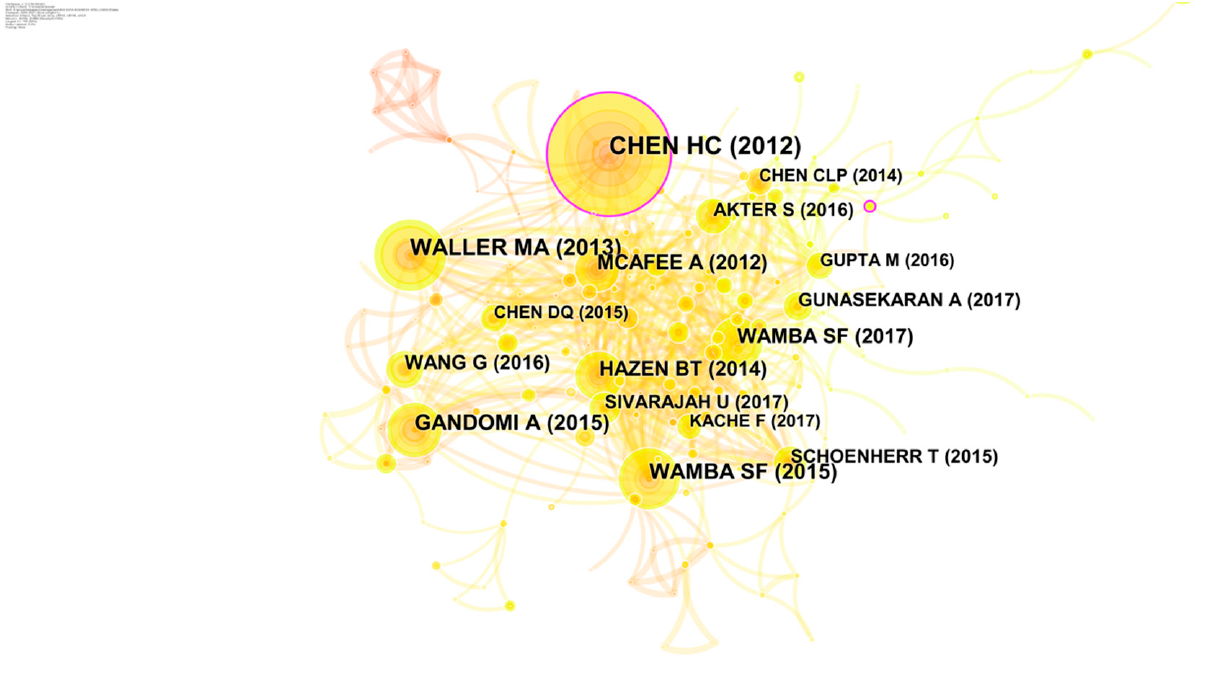
Figure 6. The distribution of cited references (The links represent citation relationship between references). Table 5. Top 5 cited references according to the number of being cited.